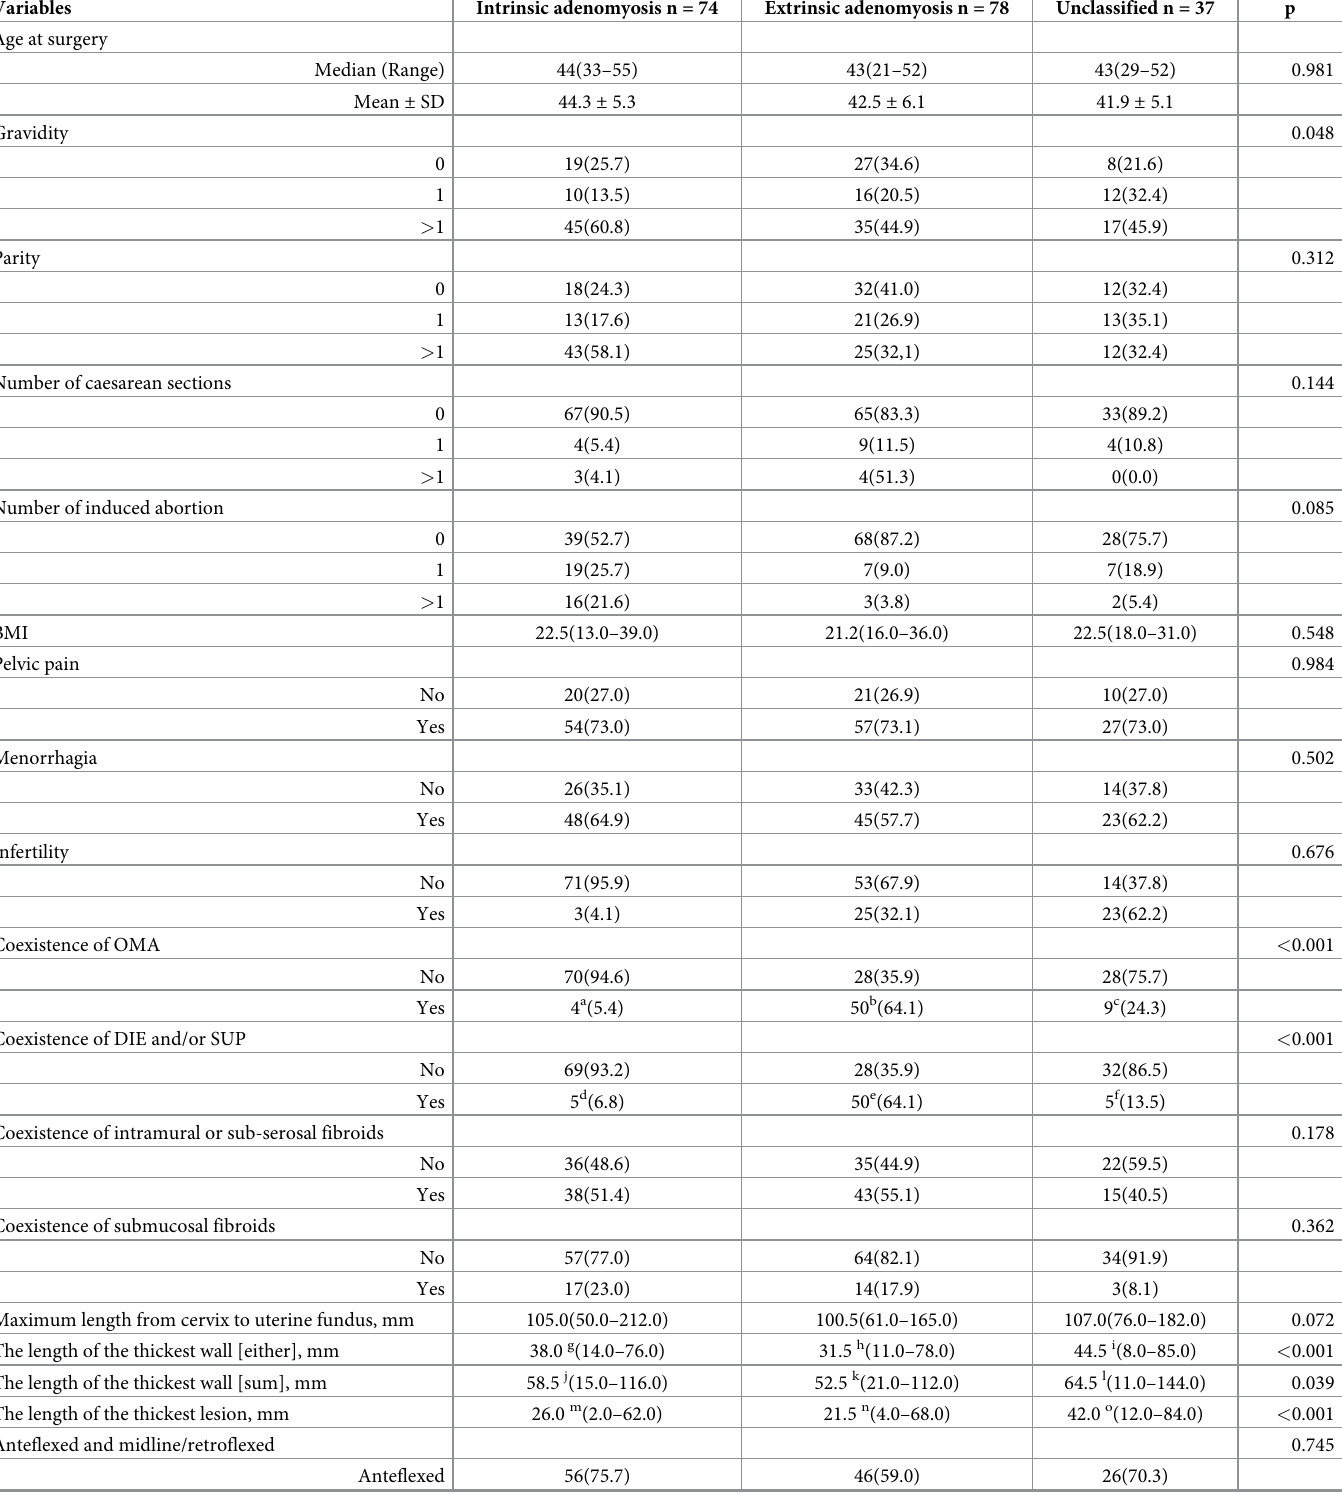
Table 1. Clinicopathological variables in patients with intrinsic, extrinsic and other types of